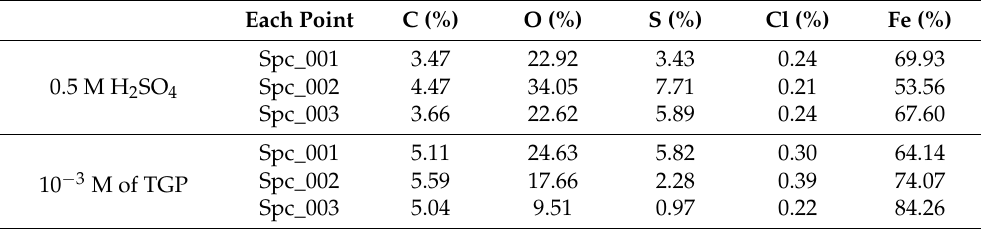
Table 3. EDS analysis of MS surface after immersion in 0.5 M H 2 SO 4 at each point with and without 10 − 3 M of TGP.